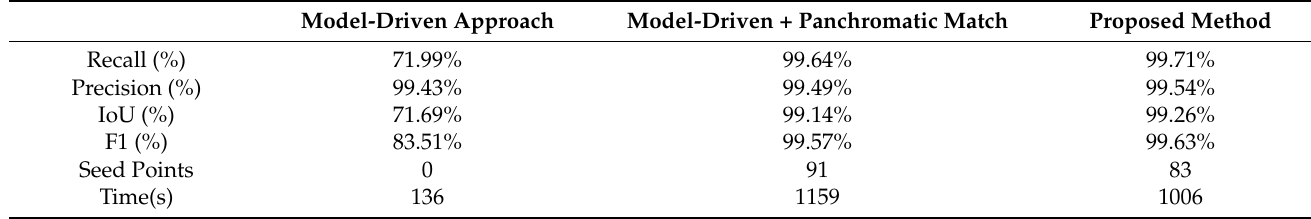
Table 2. Information table for comparison of results of different